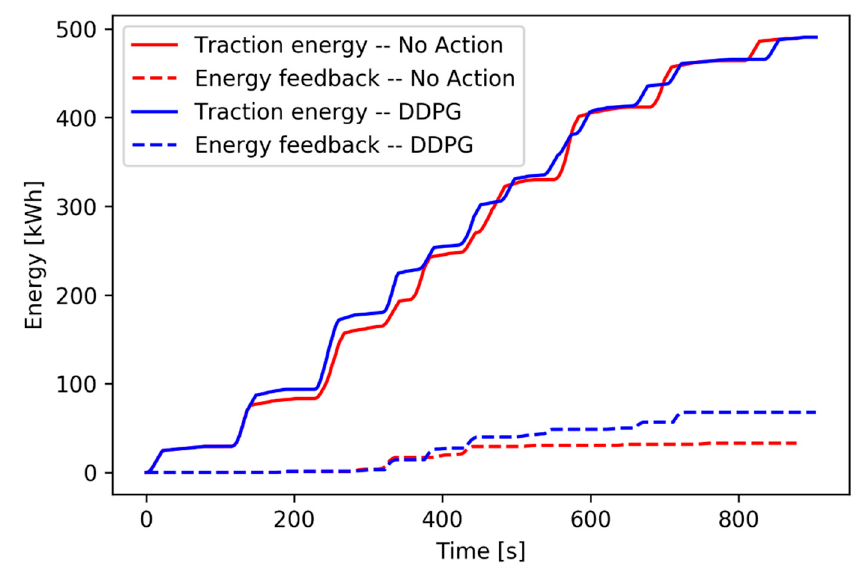
Figure 16. Energy accumulation under a 13.60 s delay in the three-train network.